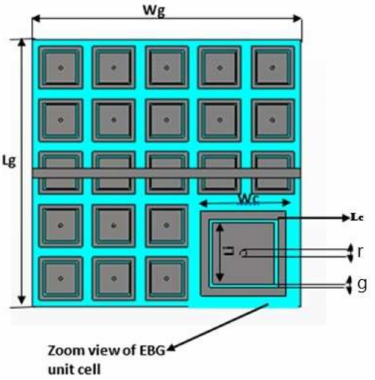
Figure 2. Geometric model of the dual-band EBG.